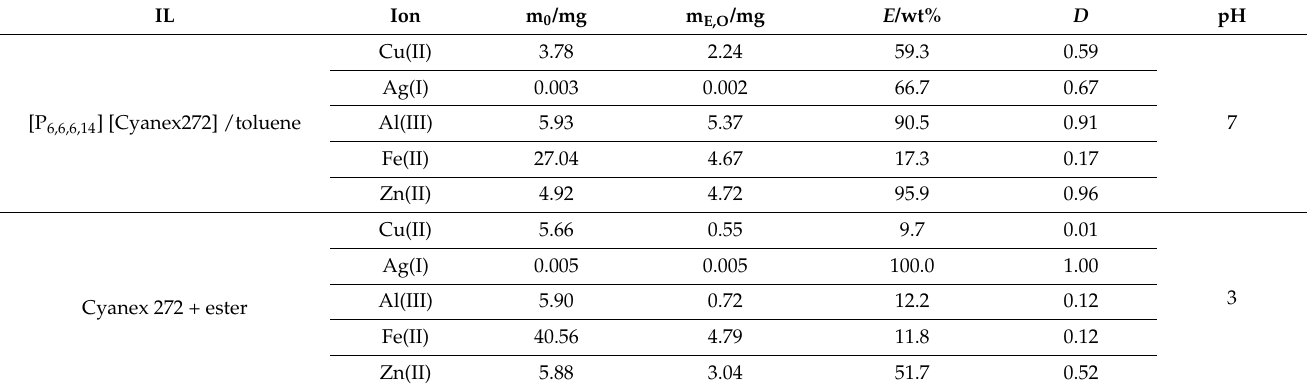
Table 7. Results of metals extraction with ILs from the post-leaching solution I, extraction efficiency ( E /wt%), distribution ratio ( D ), pH of the aqueous phase after extraction at the temperature T = 303 K. Ion m 0